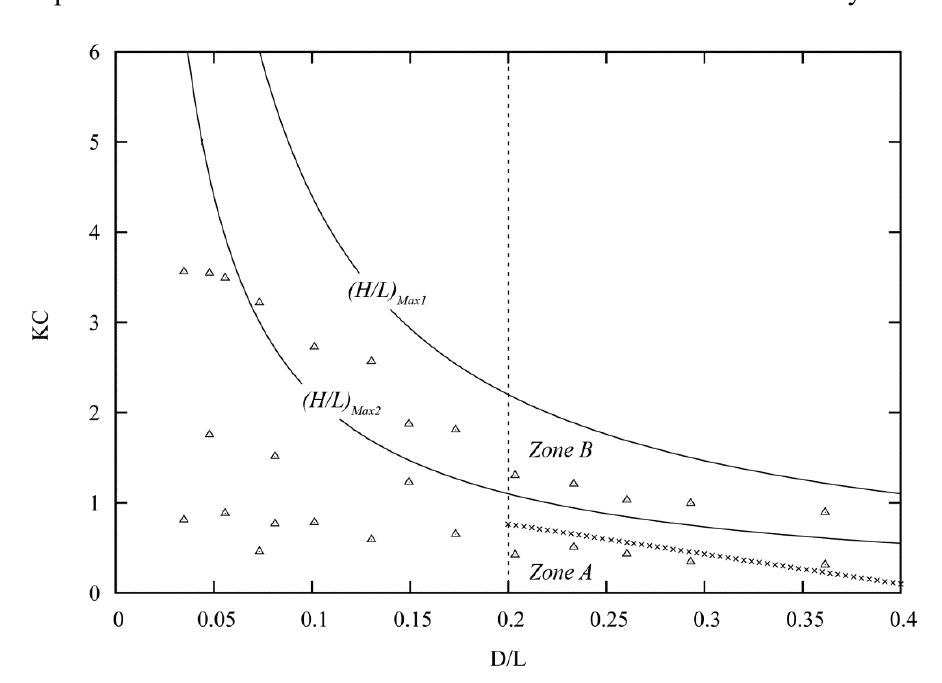
Figure 1. Scheme of wave regimes in terms of KC and D L : (××) waves selected for a preliminary evaluation of the quantities defined in Equations (10), (11), (14) and (15); ( ∆∆ ) parameters of the experimental waves [14] falling under the limit mirrored by Equation